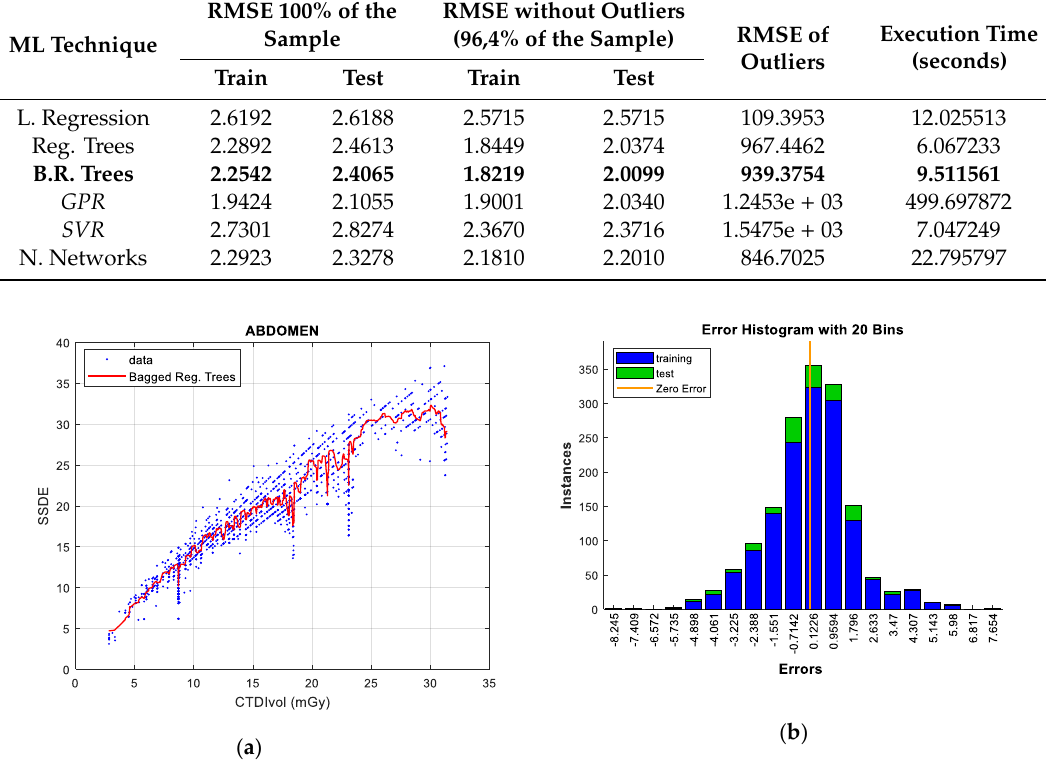
Figure 14. SSDE prediction according to CTDI VOL for Abdomen protocol ( left ), together with error histograms ( right ), the ‘ bagged ’ regression trees technique ( a , b ).